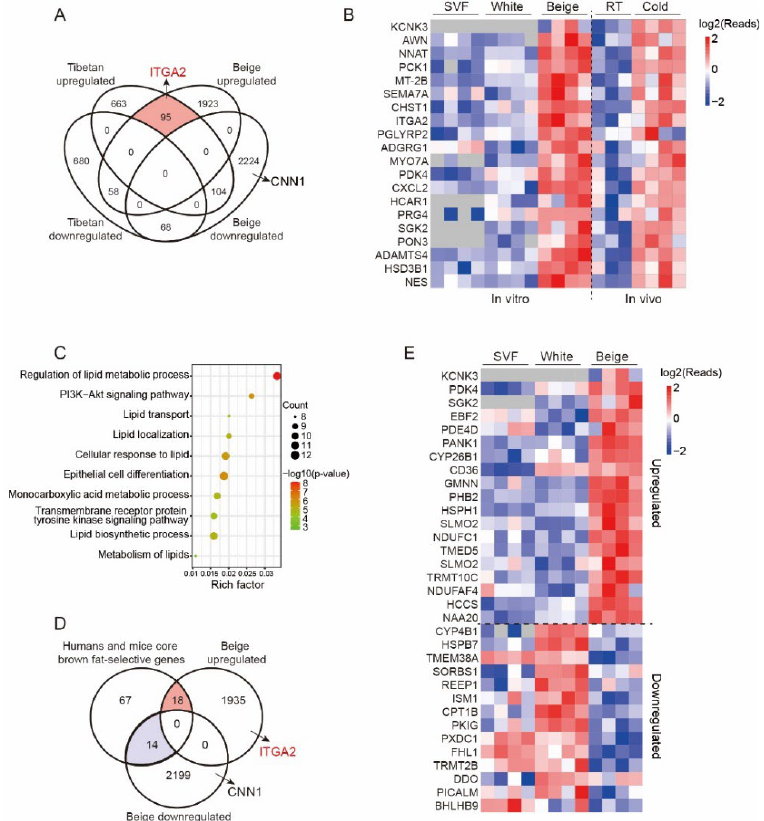
Figure 4. Comparative analysis of differentially expressed genes in beige adipocytes from different samples. ( A ). Venn diagram showing the overlapping genes that are specific and significant in the beige/white and Tibetan pig comparisons after cold stimulation (FC >1.5, p < 0.05). Note that a total of 95 upregulated genes and 68 downregulated genes were included based on the established criteria. ( B ) Expression profiles of the top 20 genes enriched in vitro and in vivo. The color scale shows the z score read counts representing the mRNA level of each gene in the blue (low expression)-white–red (high expression) scheme. RT: room temperature, cold: 4 ◦ C for 4 h. ( C ) GO analysis of 95 upregulated genes overlapping in ( A ). The dot plot shows the most significantly enriched pathways. The color of the dot represents the p value, and the size of the dot represents the number of DEGs. ( D ) Venn diagram showing the beige adipocyte-related genes specific for pigs and conserved across the species (FC > 1.5, p < 0.05). Note that a total of 18 upregulated genes and 14 downregulated genes were conserved across humans, mice and pigs. Human and mouse core brown fat-selective genes: List of core brown fat-selective genes conserved in mice and humans. ( E ) Expression profiles of the 32 genes in ( D ) conserved across the species in the SVF, white and beige